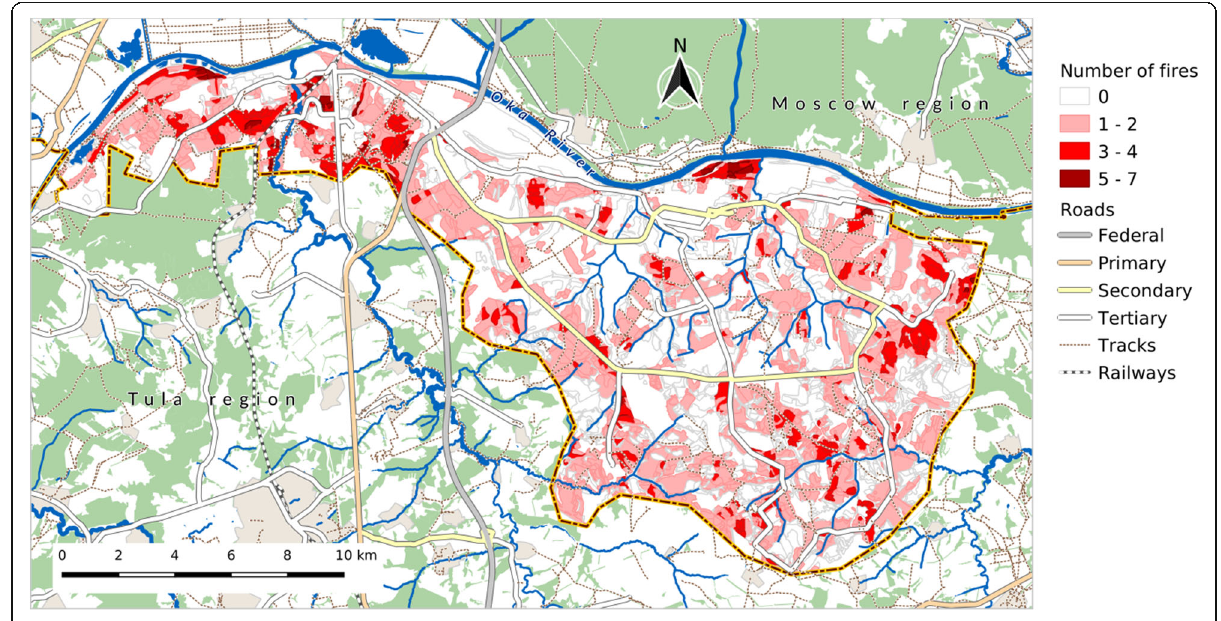
Fig. 4 Frequency of spring grass fires in the study area from 1985 to